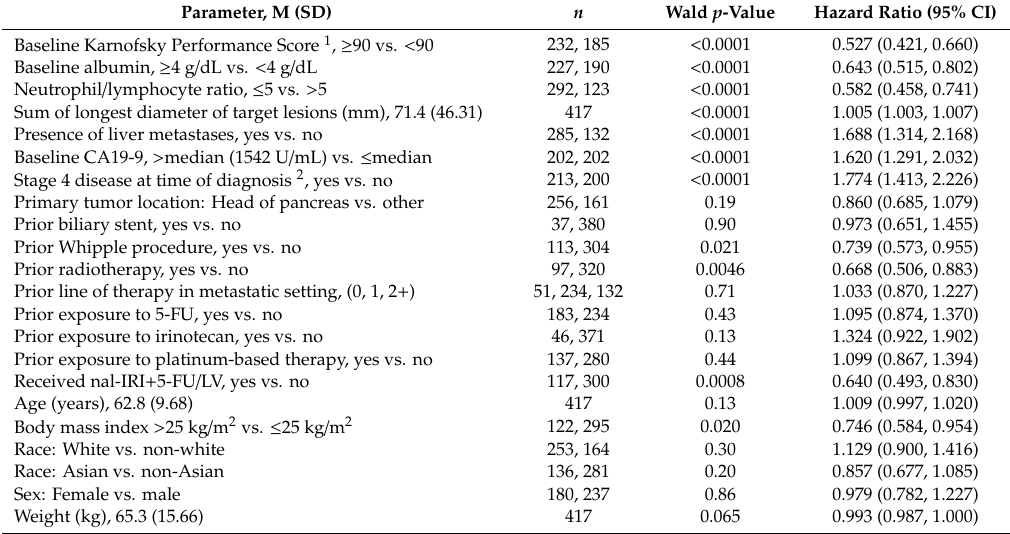
Table 1. Univariate Cox regression of overall survival ( N = 417).